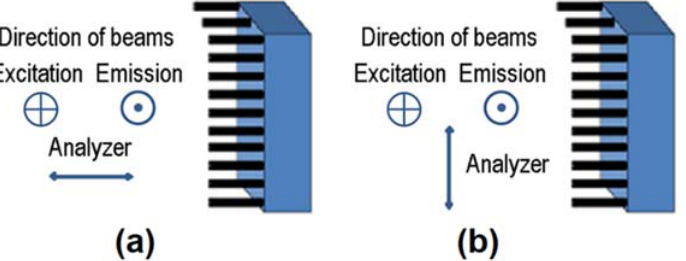
Figure 1. Schematics of polarized PL measurement with polarization along the nanowires ( a ) and polarization in the radial direction ( b ).